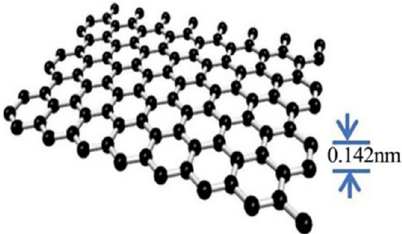
Figure 4. Schematic diagram of a single layer of graphene from graphite.